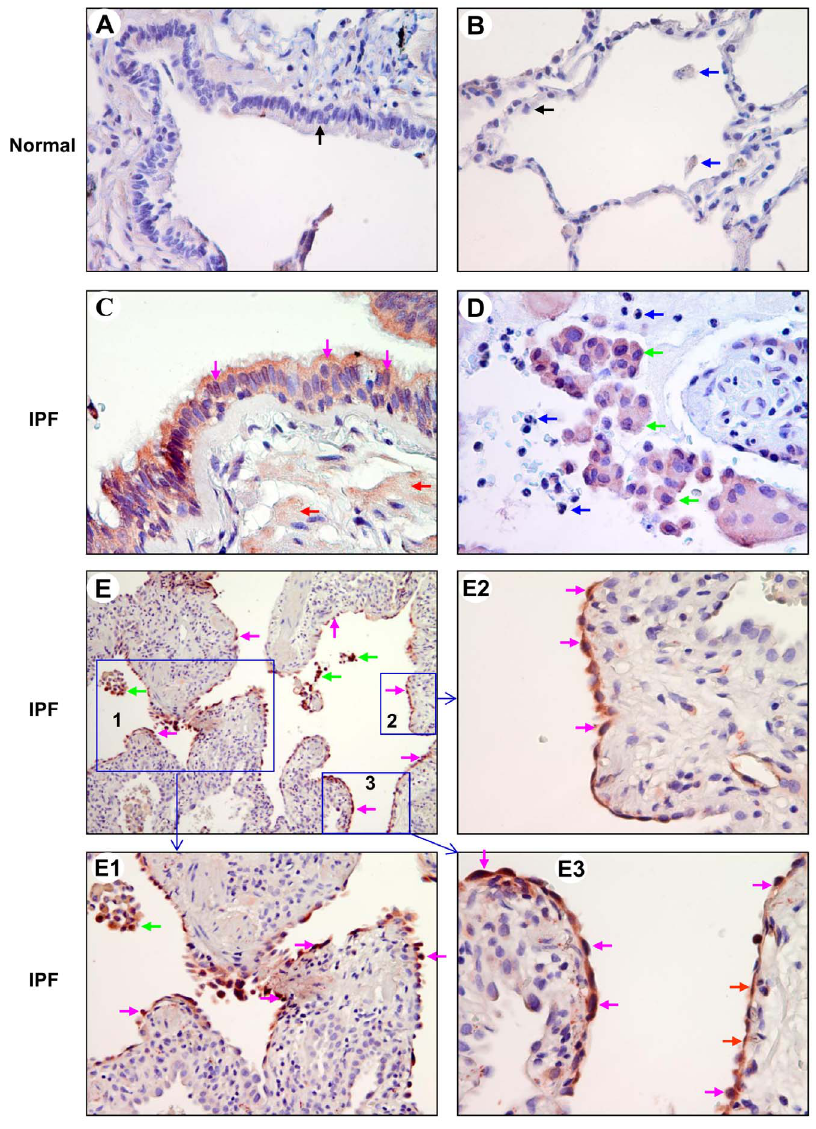
Figure 3. Expression of PKD2 in normal and IPF lung tissues. Normal and IPF lung sections were subjected to immunohistochemical analysis by a PKD2 specific antibody at a dilution of 1:300. A and B: normal lung BECs and AECs (black arrow) as well as macrophages (blue arrows) were stained negative for the PKD2 antibody. Final magnification: 6 400. C: in IPF bronchiolar epithelium, PKD2 (red) was expressed in the cytoplasm and nuclei of BECs (pink arrows) and in smooth muscle cells (red arrows). Final magnification: 6 400. D: PKD2 (red) was expressed in macrophages (green arrows) but not neutrophils (blue arrows) in IPF lung alveoli. Final magnification: 6 400. E–E3: in the fibrotic areas of IPF lung, PKD2 (red) was expressed in the flat (red arrows) and cuboidal (pink arrows) regenerative AECs lining remodeled fibrotic alveolar septa and/or fibroblast foci. It should be noted that alveolar walls grew and expanded towards the regenerative AECs overexpressing PKD2. Strong PKD2 immunoreactivity was also observed in macrophages (green arrows). The regions indicated in panel E ( 6 100) are shown at higher magnification in E1 ( 6 200), E2 ( 6 400), and E3 ( 6 400). doi:10.1371/journal.pone.0101983.g003 smooth muscle cells surrounding small airways from 67% (8 of 12) antibody. We found that the phosphorylation of PKD on Ser-744/ IPF subjects (Fig. 5C and Table 1). At the alveolar level of the IPF 748 was barely detectable in normal lung BECs, AECs and lung tissues, Fig. 5 (E and E 9 ) shows an area of alveolar septa macrophages (Fig. 5, A and B). In contrast, the immunoreactivities surrounded by acellular collagen bundles. The alveolar walls were were detected with a weak to strong intensity in IPF BECs, AECs, thickened by collagen deposition and there was a hyperplasia of and infiltrated macrophages by the PKD-pSer744/748 antibody type II pneumocytes, and most of the hyperplastic type II (Fig. 5, C–F 9 ; Table 1). Specifically, the cilia, cytoplasm and nuclei pneumoctyes were stained positive in cytoplasm and nuclei for of IPF bronchiolar and honeycomb cyst epithelia were all stained the PKD-pSer744/748 antibody. Moreover, PKD phosphoryla- positively by the antibody (Fig. 5, C and D). Honeycomb cysts are tion on Ser-744/748 was also readily detected in the regenerative defined as mucus-containing cysts that contain less invaginated AECs lining remodeled fibrotic alveolar septa and/or fibroblast airway epithelium [25]. Positive staining was also observed in the